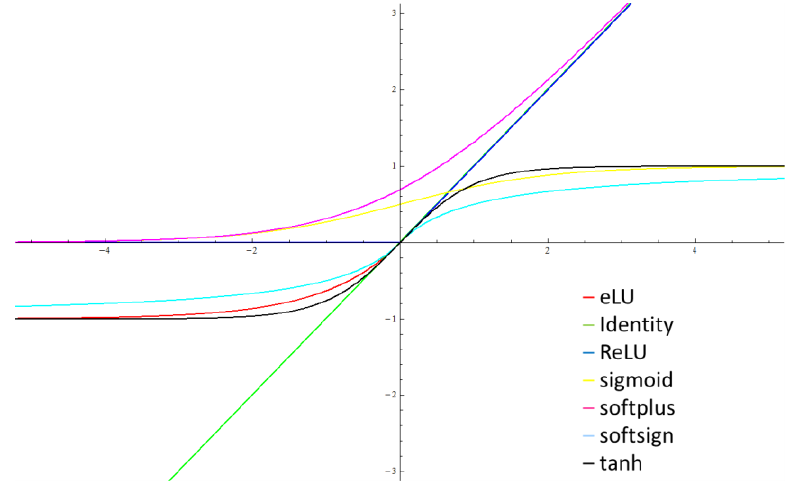
Figure 2. The activation functions employed.